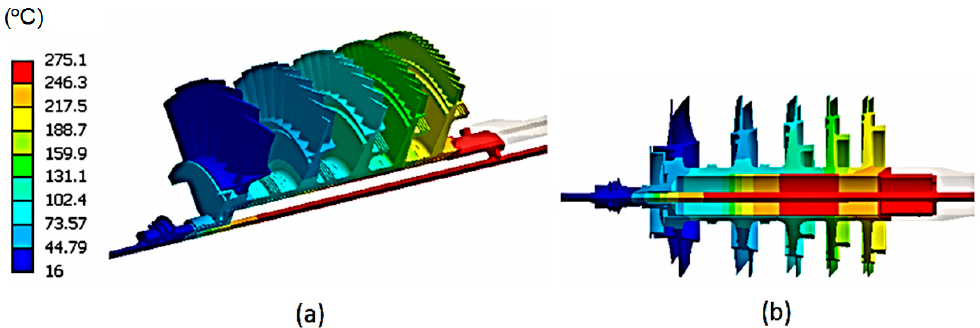
Figure 8. Temperature distribution over the compressor disc and shaft: ( a ) Perspective view; ( b ) Inner shaft view.